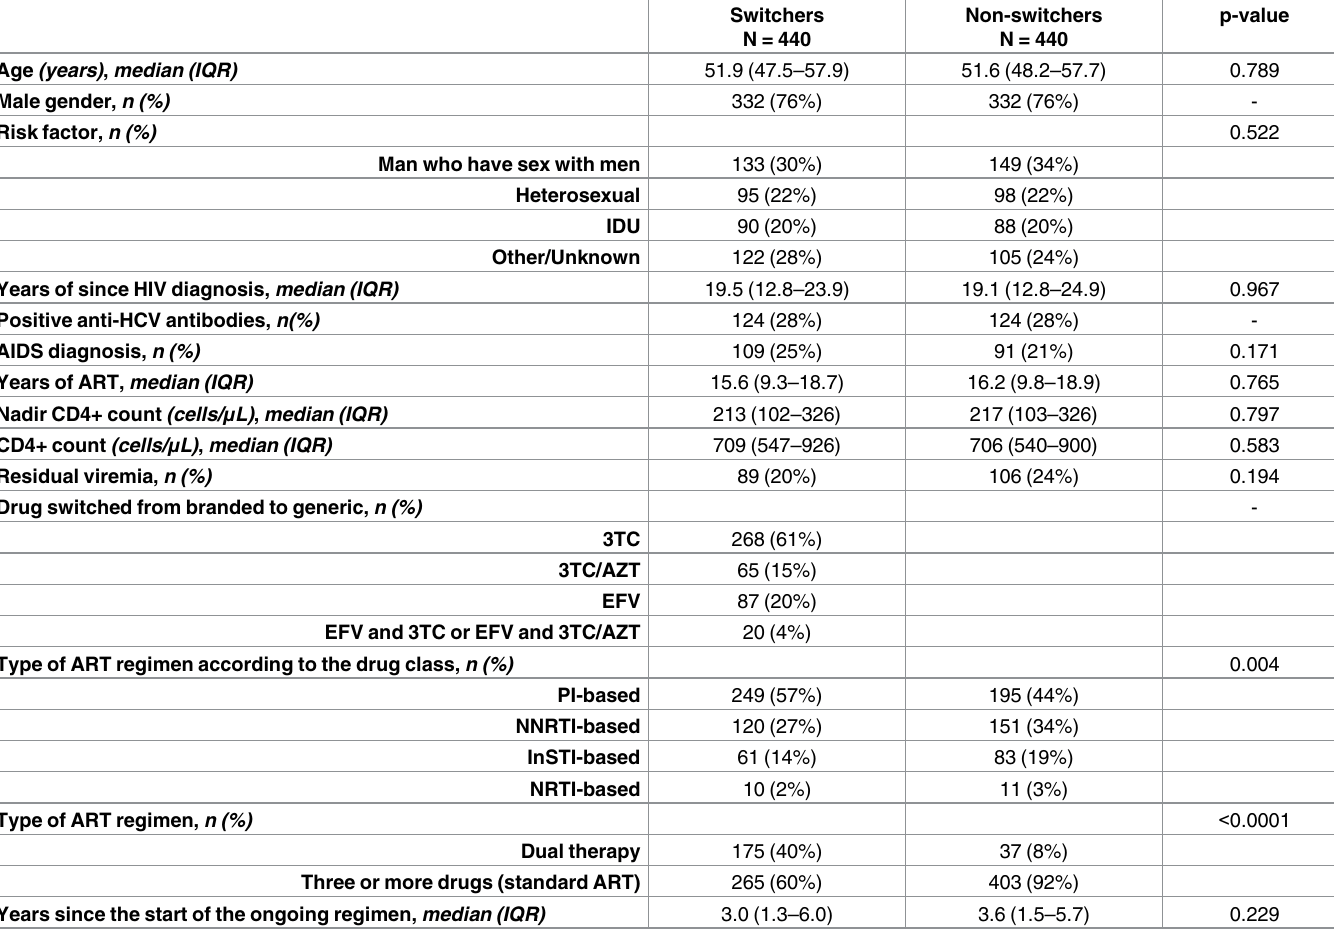
Table 1. Baseline